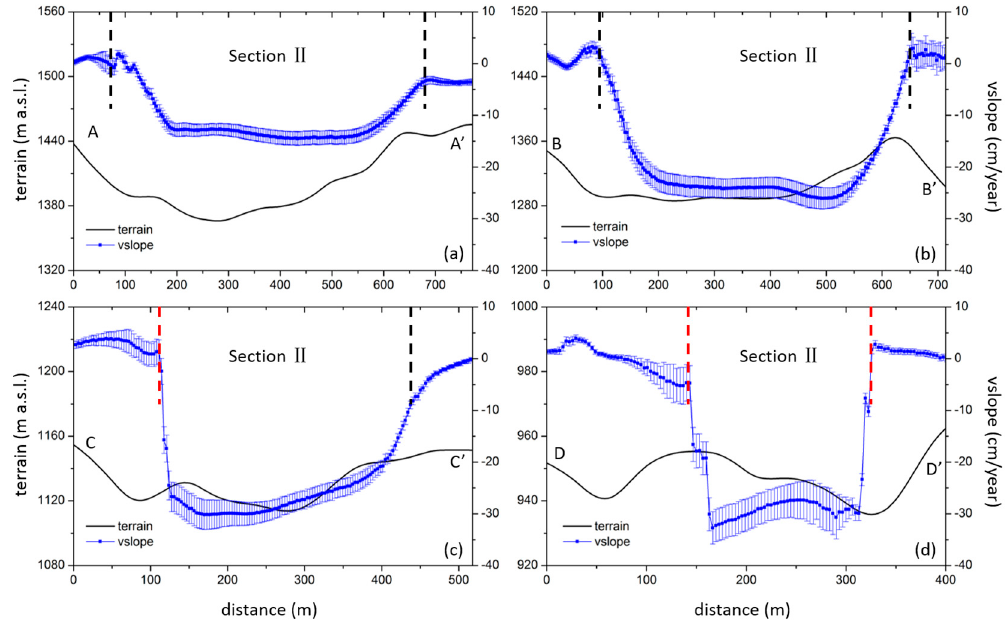
Figure 7. Cross-sections of annual landslide slip rate in the downslope direction along ( a ) profile AA’; ( b ) profile BB’; ( c ) profile CC’ and ( d ) profile DD’ marked in Figure 6. The solid curve shows the elevation in each panel; error bars represent the standard deviations of the estimated slip rate. The boundaries of Section II of the Jinpingzi landslide are indicated with dashed lines at the top of each figure, and the red dashed lines represent the slide-bounding strike-slip fissures.